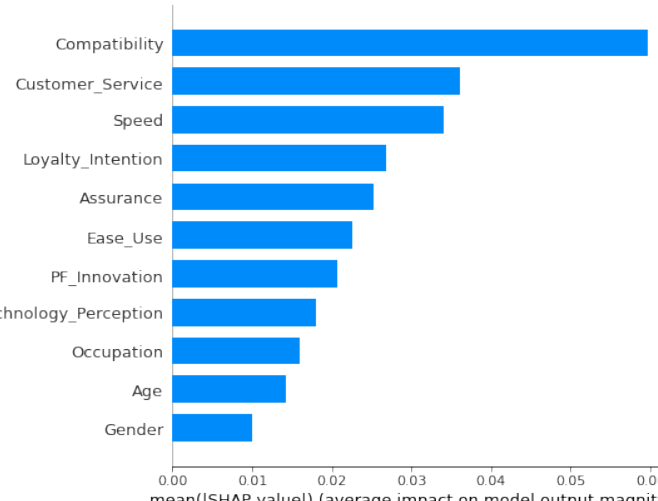
Figure 4. SVM—Interpretation with SHAP.